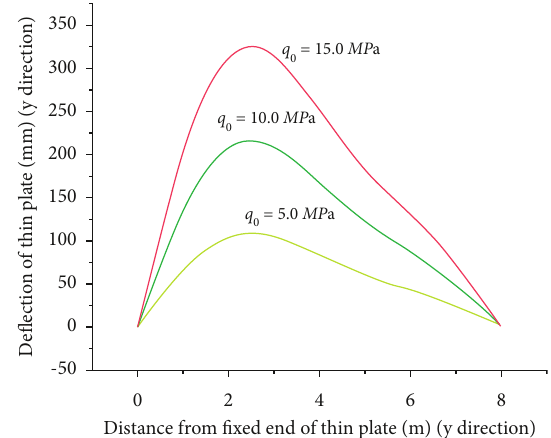
Figure 5: Variation curve of roof deflection under different overlying strata